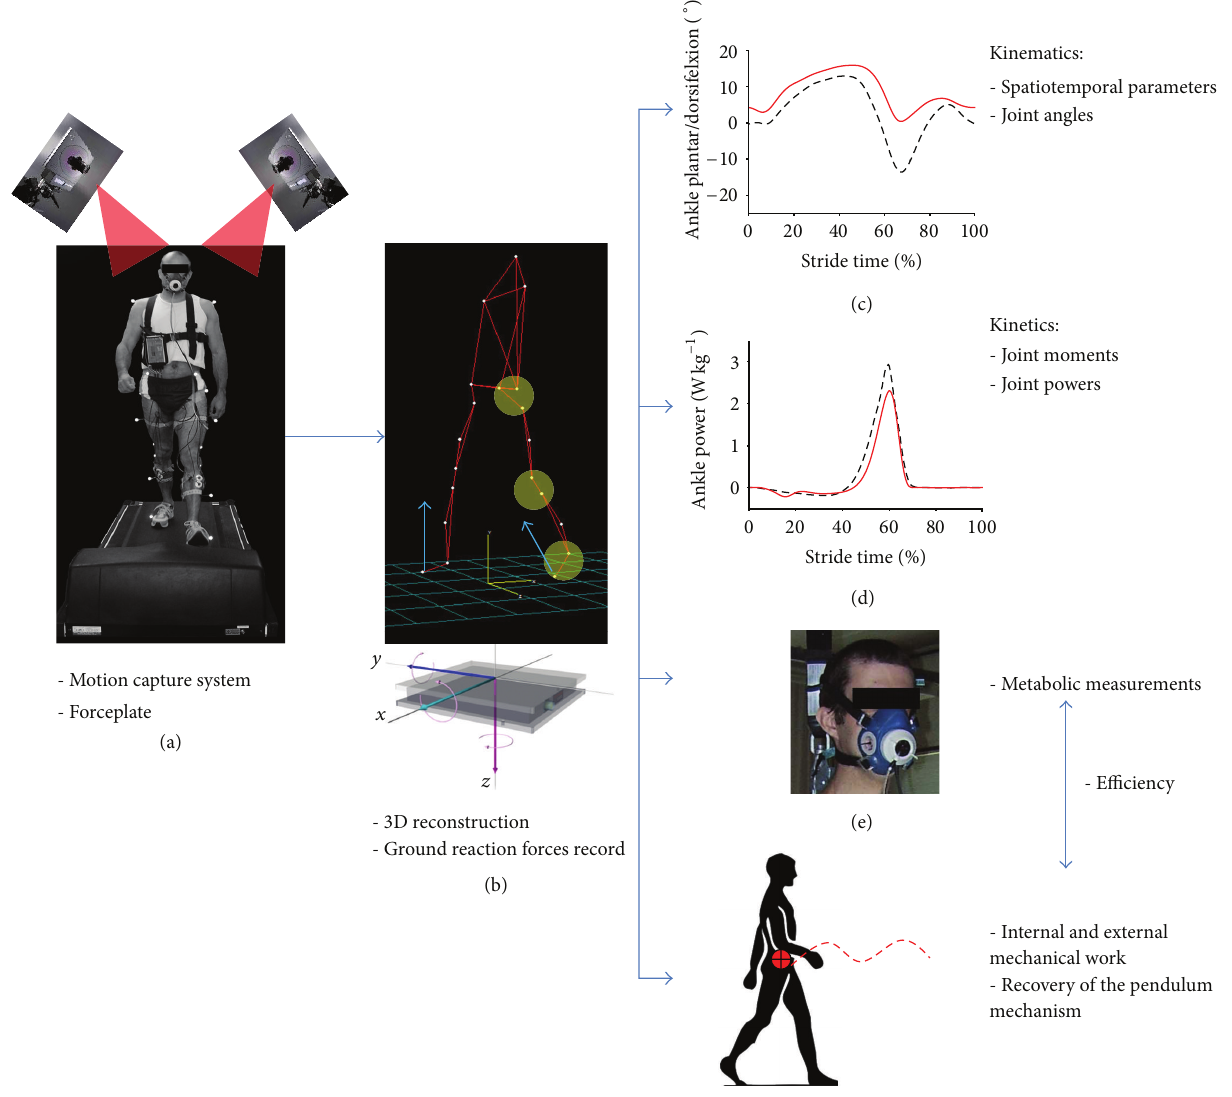
Figure 1: The infrared cameras (a) are positioned so that at least two visualize each reflective marker at any given time. From the reflective markers movements we can calculate the 3D trajectories of the body segments (b). The images are then processed to derive the graphs of the kinematics, that is, the joint range of movement of each lower limb joint (c). A force platform located under the treadmill (b) records the patient’s ground reaction forces. The joint moments and powers, that is, kinetic data, (d) are derived from force platform measurements and kinematic data. Energy expenditure is measured indirectly based on the rate of oxygen consumption by the patient using an ergospirometer (e). Finally, the mechanical work is calculated as the work performed by muscles to raise and accelerate the center of body mass (external mechanical work) and to move the body segments relative to the center of body mass (internal mechanical work) (f).